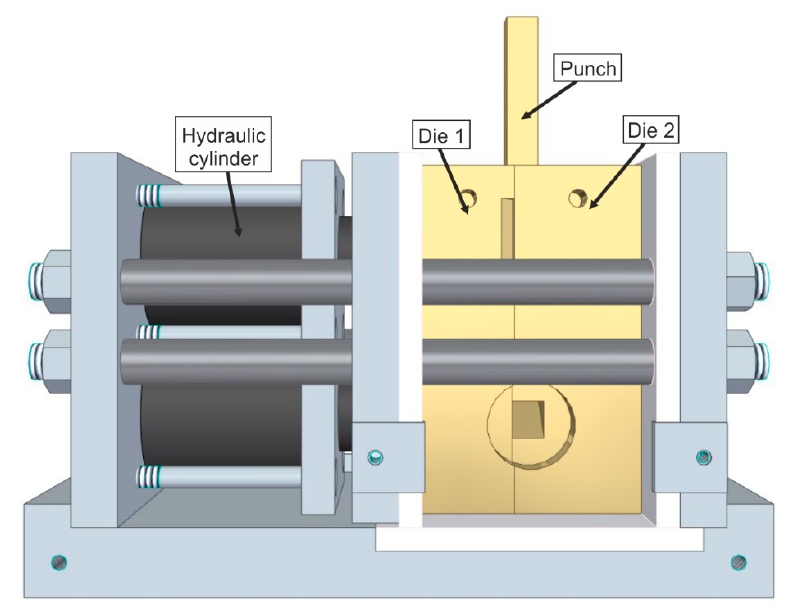
Figure 2. Design of the equal channel angular pressing tool.